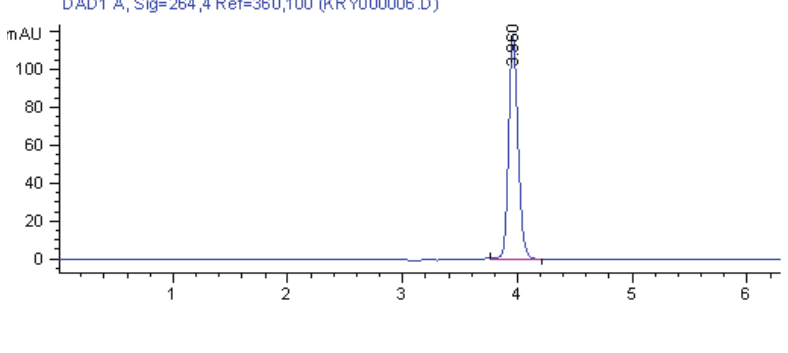
Fig. S4b HPLC Chromatogram of gallic acid at 264 nm and 3.96 min